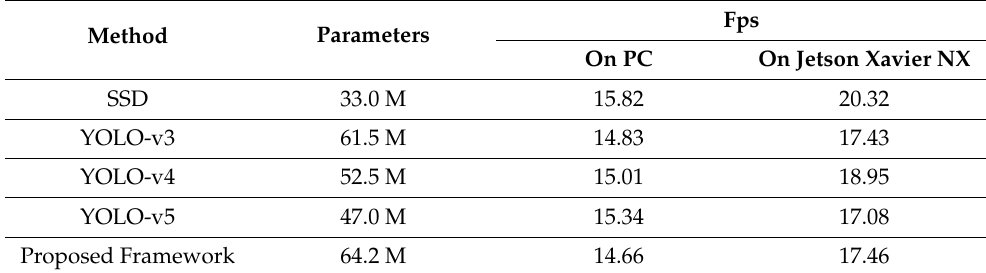
Table 4. Detection real-time comparison of proposed framework with the classical one-stage